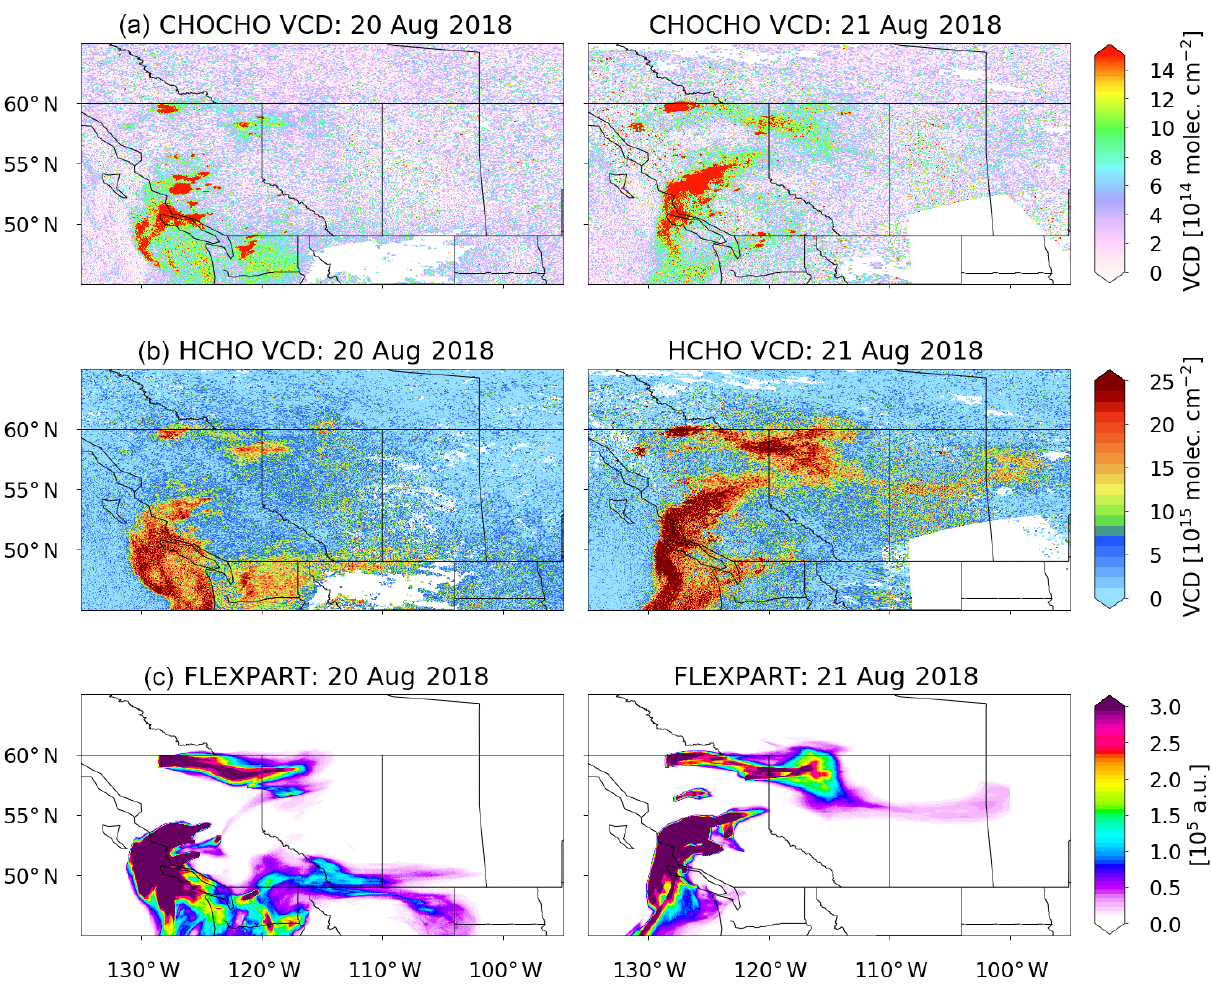
Figure 7. (a, b) Daily CHOCHO and HCHO VCDs retrieved from S5P measurements for the period from 20 to 21 August 2018. (c) Tracer distribution simulated with FLEXPART for the same period assuming a lifetime of 28.9h. Enhanced CHOCHO columns spread over the ocean in a pattern similar to that simulated by the model